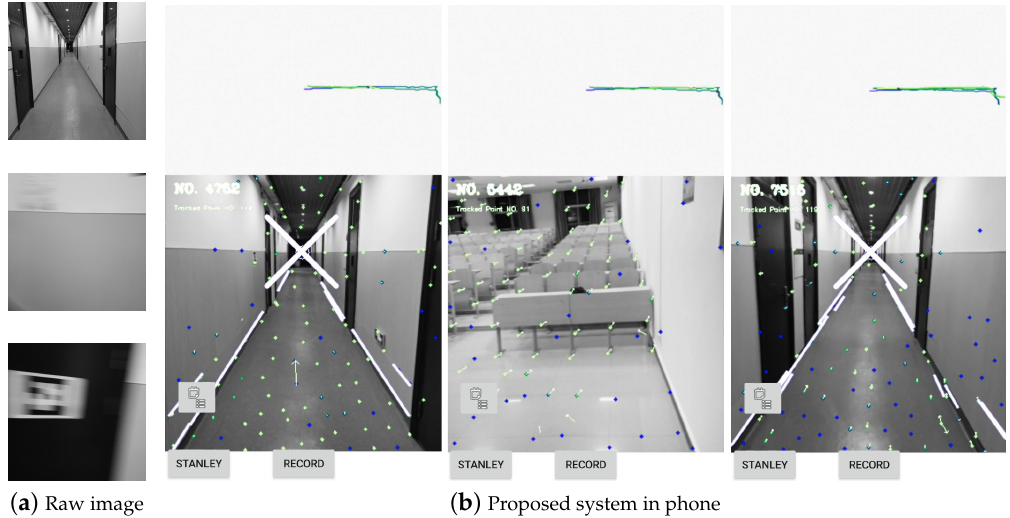
Figure 12. Subfigure ( a ) are images we collect in the corridor using an Android phone. It can be seen that texture-less area and the image blur appear in our experiment. Subfigure ( b ) shows the real-time operation of our system on the mobile phone, where the top of the image is the estimated trajectory. As can be seen, after we walk back and forth along the corridor three times, the trajectory is still in a straight line.